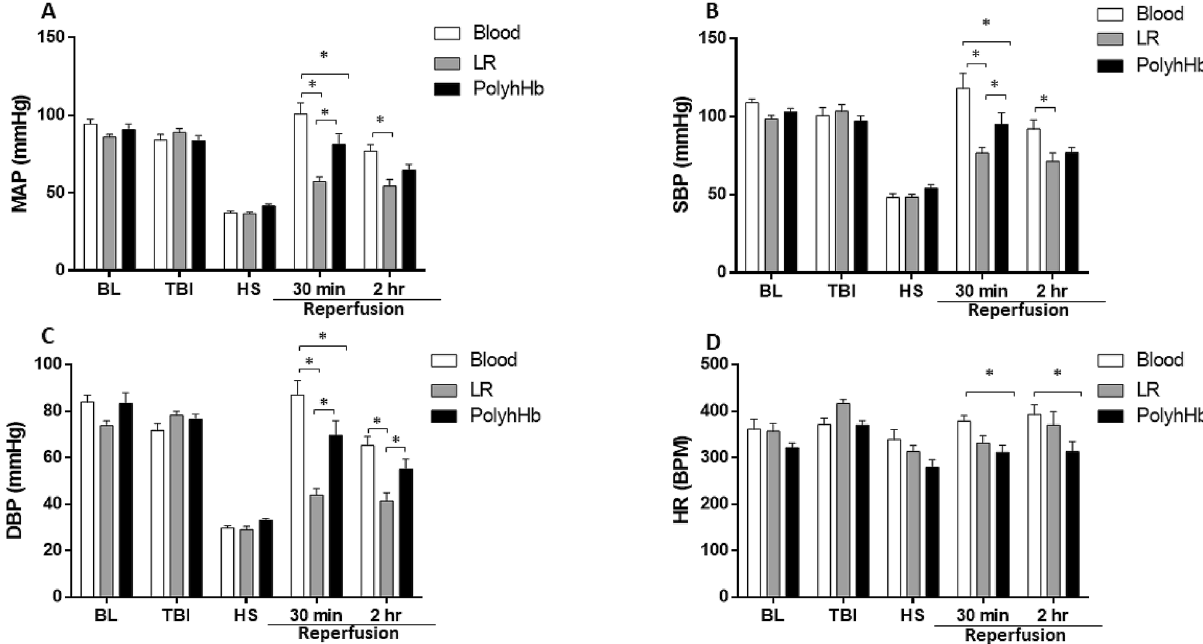
Figure 1. Hemodynamic parameters during the polytrauma protocol. ( A ) Mean arterial pressure (MAP); ( B ) systolic blood pressure (SBP); ( C ) diastolic blood pressure (DBP); ( D ) heart rate (HR). At BL (baseline); TBI (post traumatic brain injury); HS (hemorrhagic shock); 30 min into resuscitation; 2 h into resuscitation. LR Lactated Ringer’s solution. *p < 0.05. N =